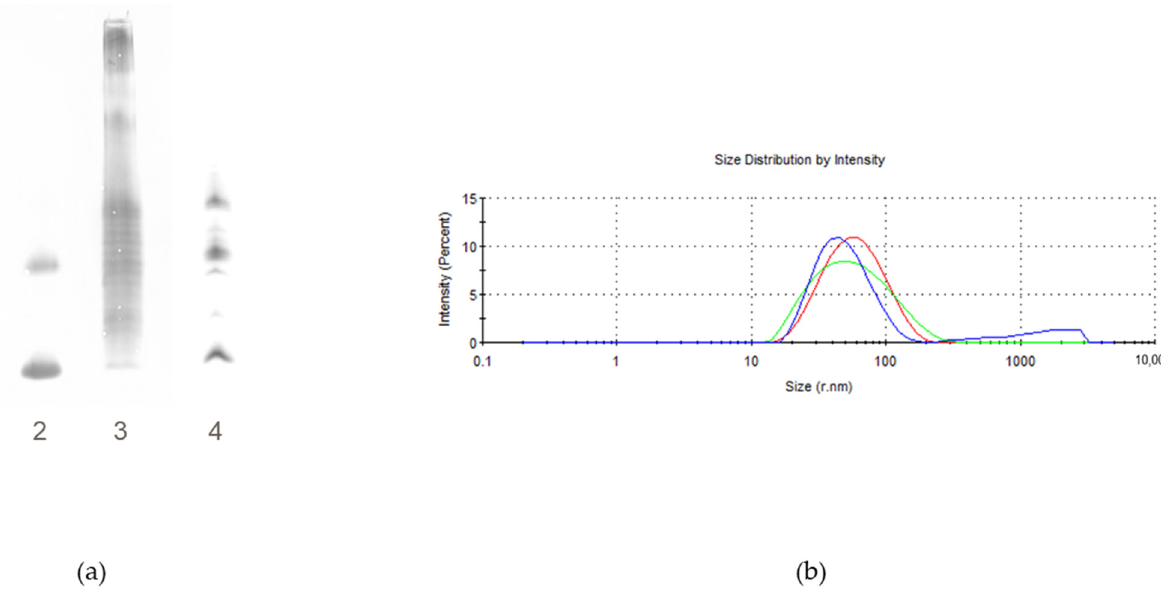
Figure 5. Impact of GMMA ‐ BS3 activation degree on conjugation efficiency. Conjugate characterization. ( a ) WB analysis of the purified conjugates in comparison to corresponding unconjugated protein. Ten μ g of conjugates and 2 μ g of protein were loaded per well. Lane 1: marker, lane 2: Pfs25, lane 3: conjugate with 32% activated GMMA ‐ BS3, lane 4: conjugate with 11% activated GMMA ‐ BS3. ( b ) dls analysis of GMMA (red line, Z average r of 52.0 nm, PdI of 0.209); GMMA ‐ BS3(32% activation) (green line, Z average r of 47.1 nm, PdI of 0.245) and GMMA ‐ BS3 ‐ Pfs25 conjugate (blue line, Z average r of 49.8 nm, PdI of 0.329 nm), confirming no crosslinking after GMMA derivatization with BS3 linker and conjugation to Pfs25.